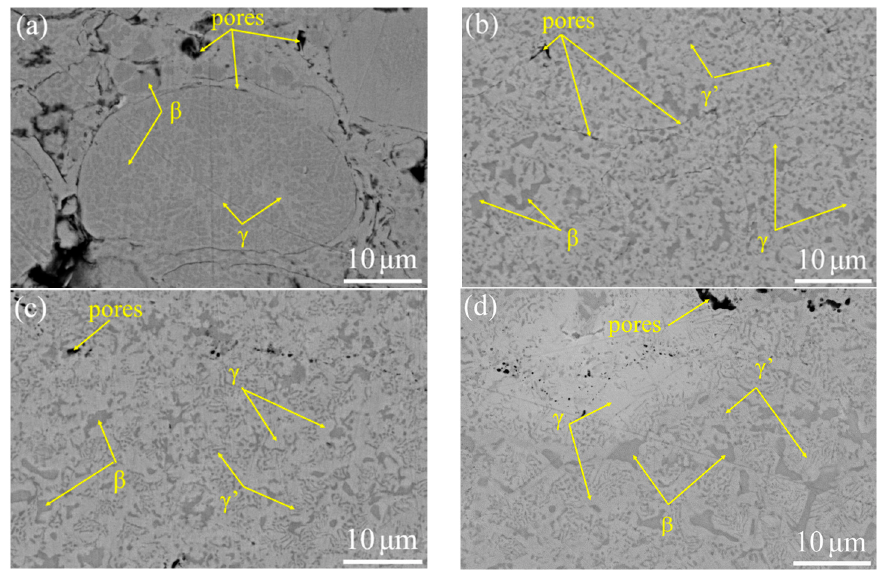
Figure 4. Internal microstructure of the as-sprayed and prepared coatings after vacuum heat treatment (VHT) at different temperatures. ( a ) As-sprayed, ( b ) VHT1000, ( c ) VHT1100, and ( d ) VHT1200. Table 3. The porosity of the as-sprayed coating and VHT coatings.